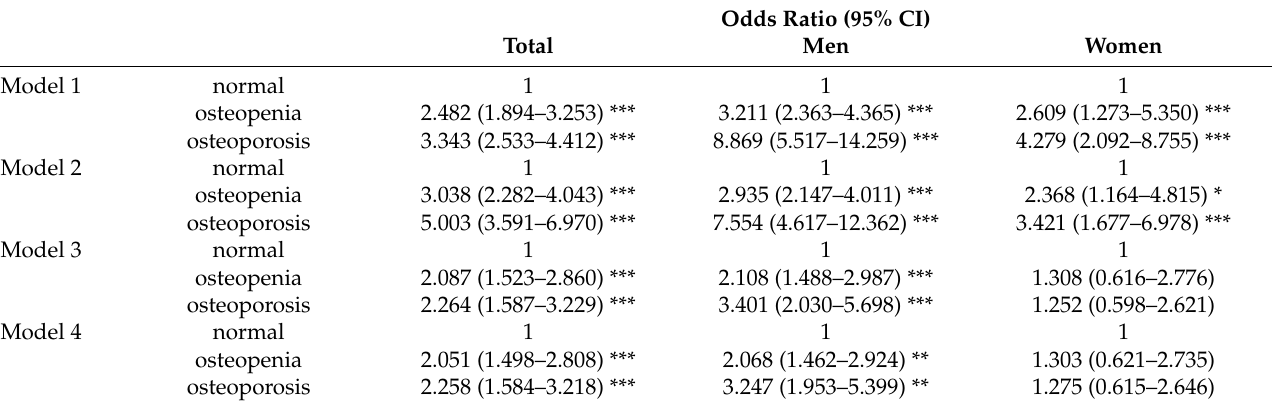
Table 4. Odds ratios for osteopenia and osteoporosis stratified by sex according to sarcopenia status. Odds Ratio (95% CI) Total Men